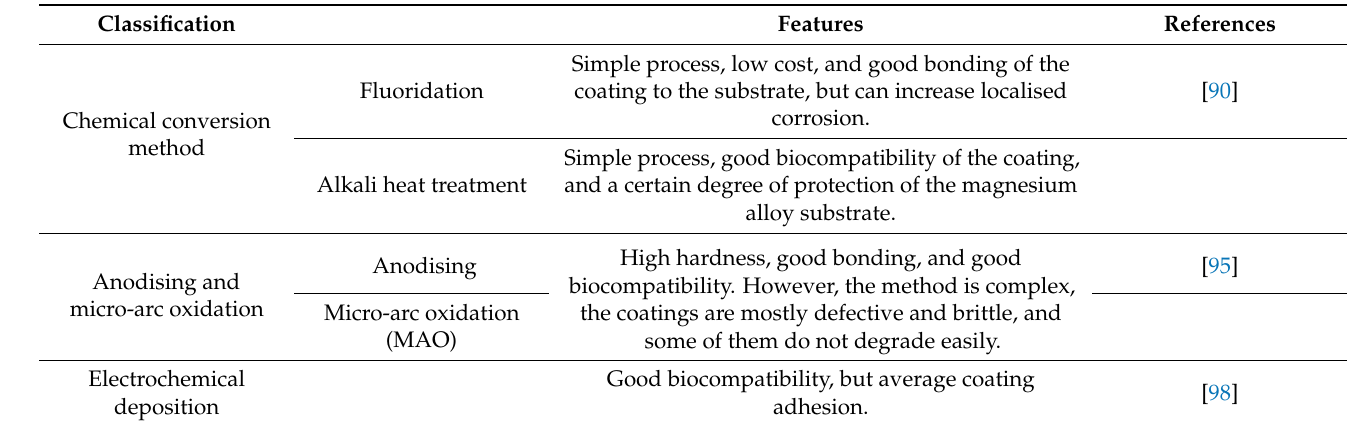
Table 1. Common surface modification techniques and their